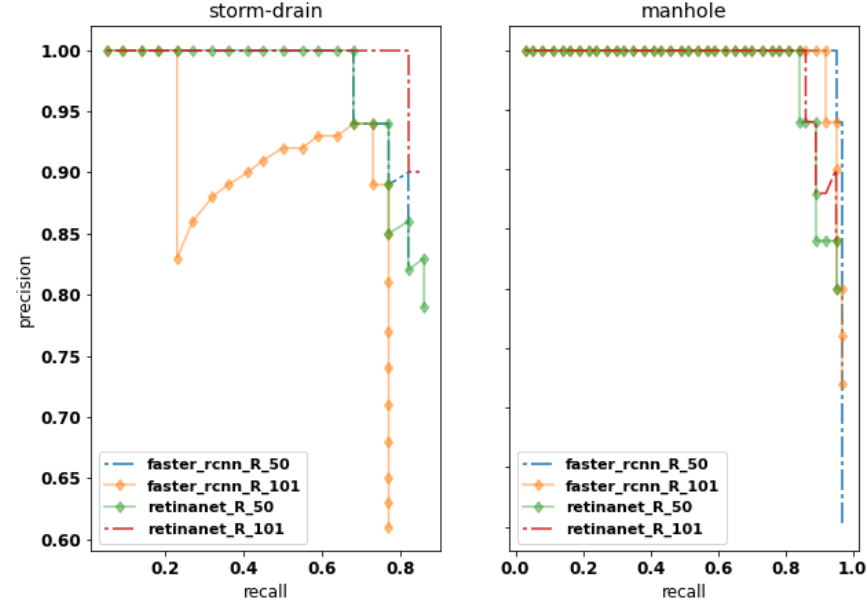
Figure 6. Precision–recall curves for all methods (R_50 and R_101 means ResNet-50 and ResNet-101, respectively) to the division 66-15-19 on IoU threshold at 0.5